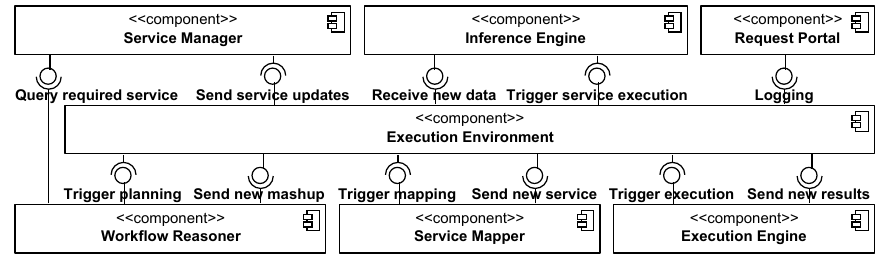
Figure 3. Workflow planning and service execution